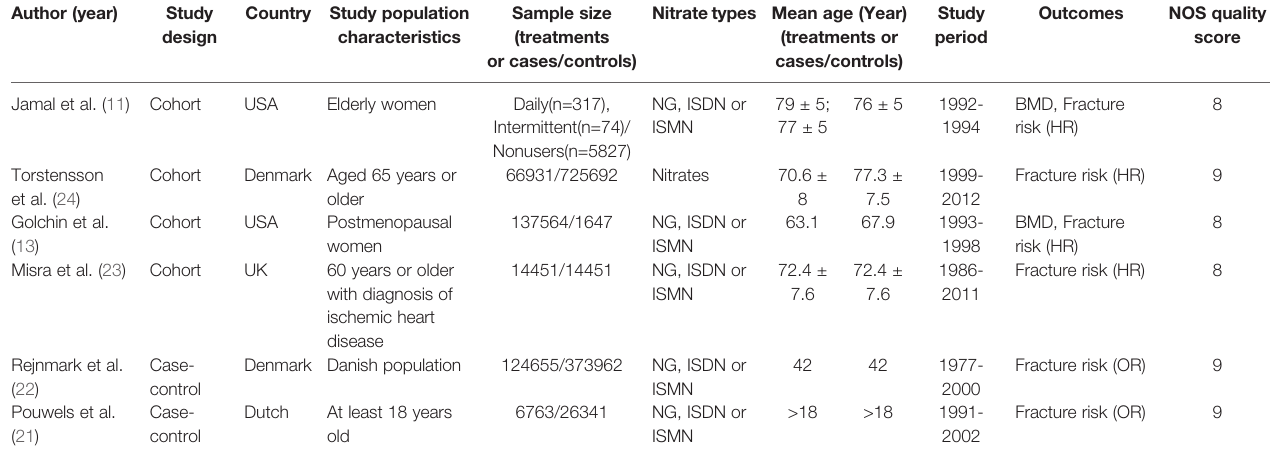
TABLE 1 | Characteristics of the six included observational